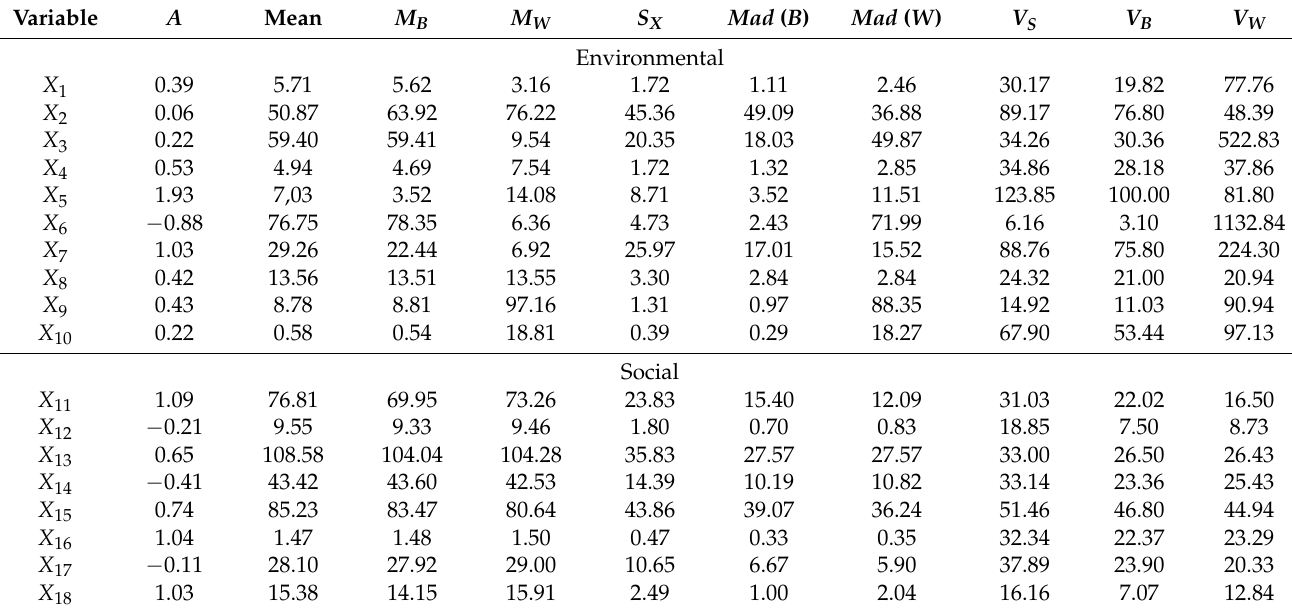
Table 2. Chosen statistical measures of the set of potential